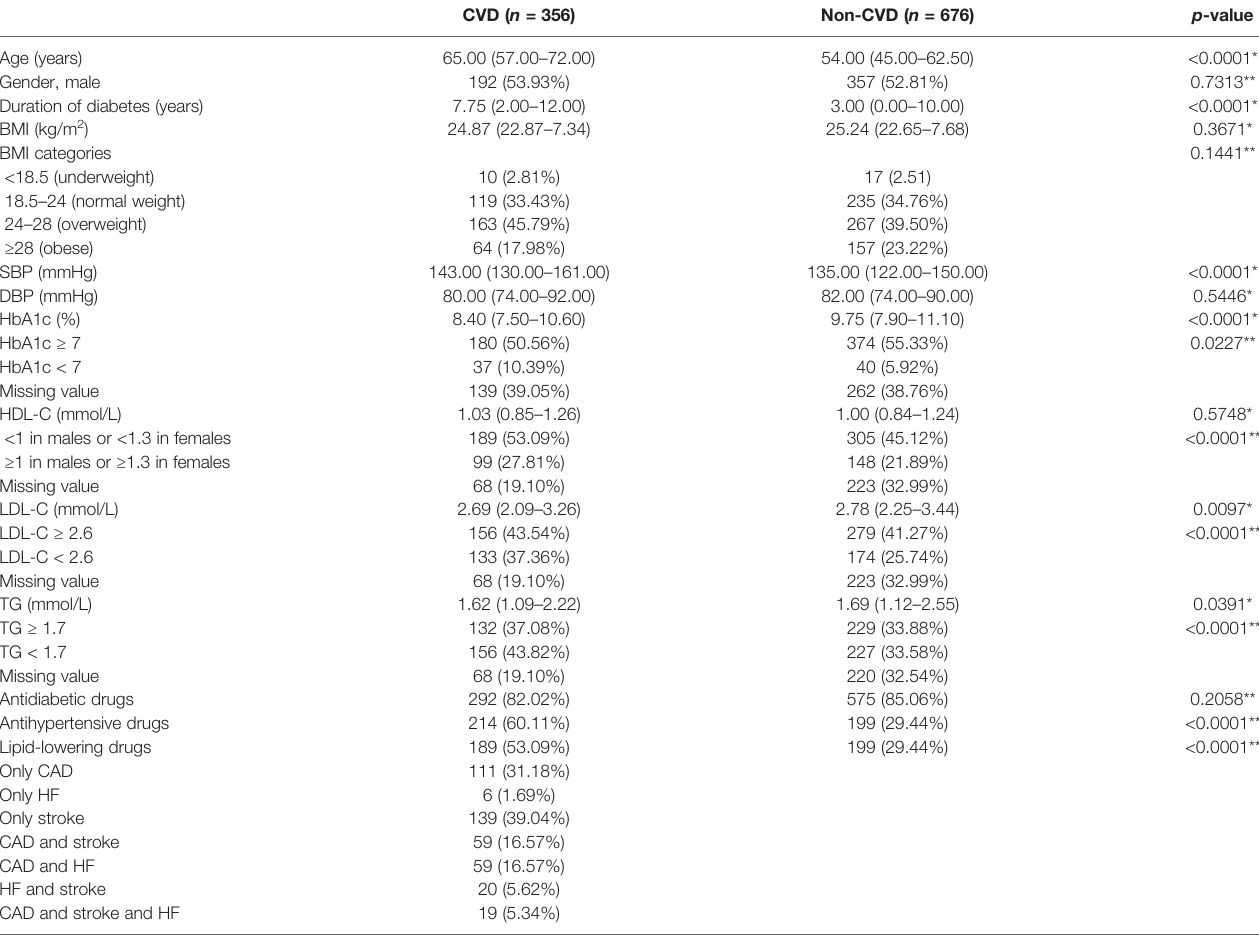
TABLE 1 | Demographic and clinical characteristics of diabetes according to occurrence of CVD.